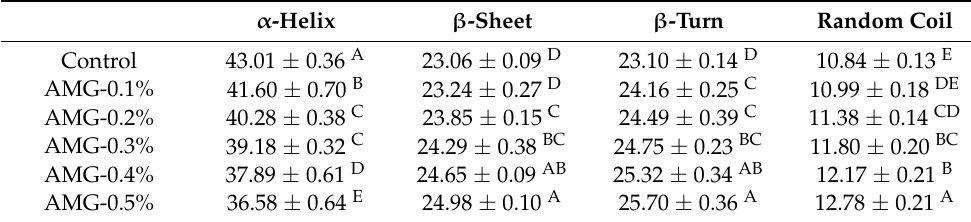
Table 5. The percentages (%) of the protein secondary structure of frankfurters with or without AMG at different concentrations.